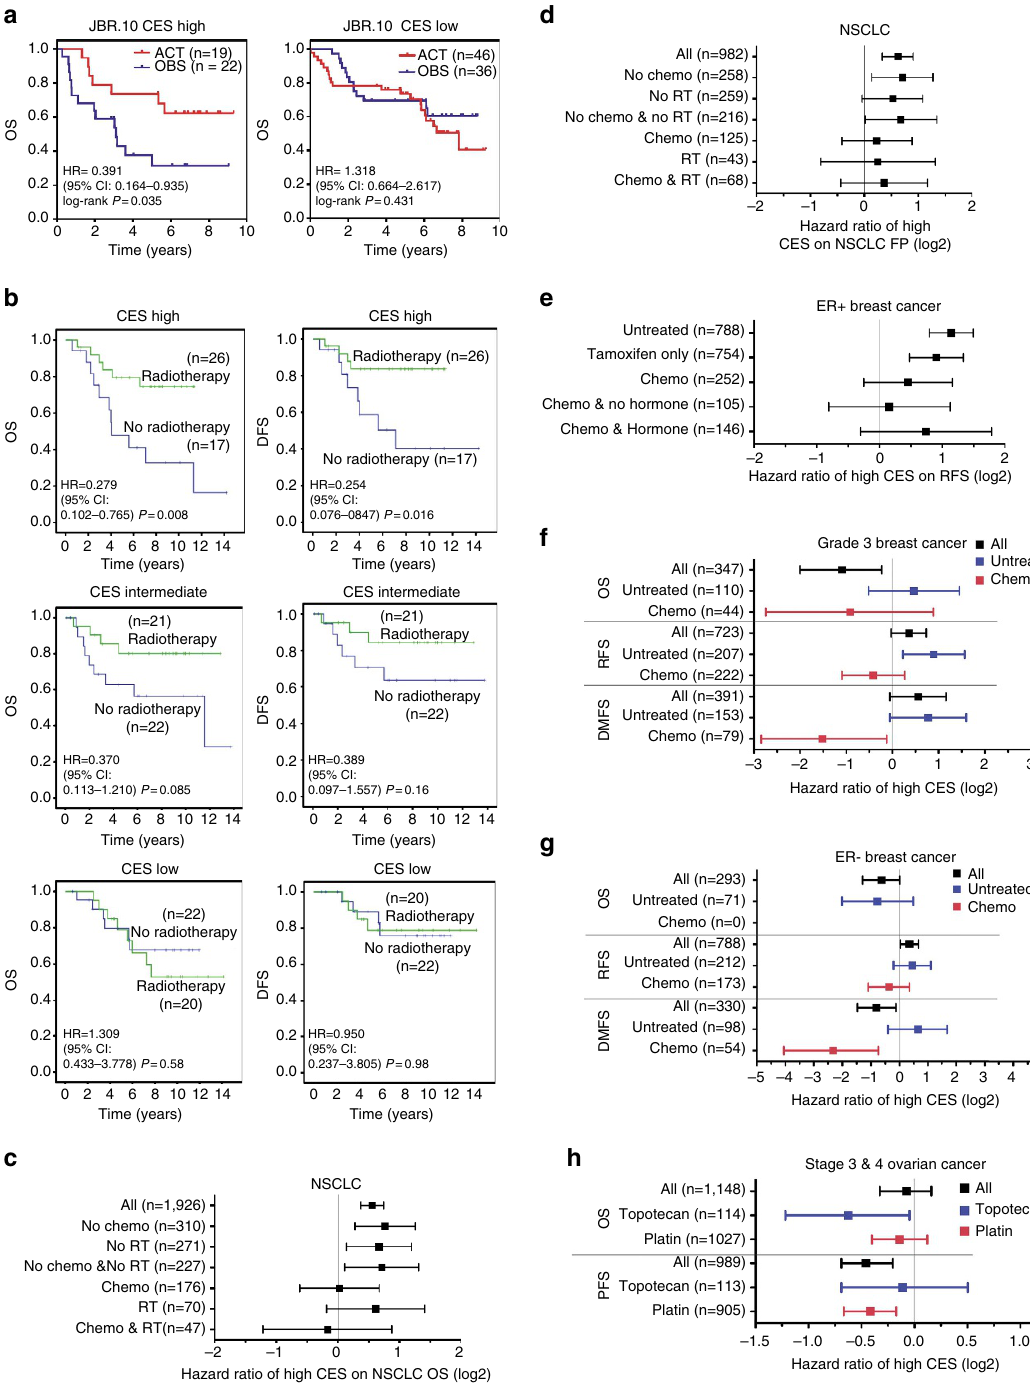
Figure 7 | CES predicts cancer patient outcome after adjuvant chemotherapy or radiotherapy. ( a ) Kaplan–Meier plots showing that high CES predicts better patient outcome after adjuvant chemotherapy (ACT) for early-stage NSCLC patients in JBR.10 trial. ACT significantly improved overall survival compared to no ACT (OBS) specifically for the high CES group (top tertile), but not for the low CES group (lower two tertiles). ( b ) Kaplan–Meier plots showing that high CES predicts better patient outcome after adjuvant radiotherapy (RT) for (left) overall survival (OS) and (right) disease-free survival (DFS) for breast cancer patients using the Gray data set (E-TABM-158). Patient cohort was divided into CES tertiles. There is no significant survival benefit from RT for patients with intermediate (middle) and low (bottom) CES. ( c – h ) Forest plots summarizing treatment-specific hazard ratios of high CES in cancer patient cohorts using K–M Plotter. Squares and error bars in the plots denote log2 scales of hazard ratio (HR) and 95% confidence interval (CI), respectively. ( c ) NSCLC patient overall survival (OS) with or without chemotherapy or radiotherapy (see Supplementary Fig. 27 for Kaplan–Meier plots). ( d ) NSCLC patient first progression (FP) (Supplementary Fig. 29). ( e ) ER þ breast cancer patient relapse-free survival (RFS) with or without tamoxifen or chemotherapy (Supplementary Fig. 30). ( f ) Grade 3 breast cancer patient survival with or without chemotherapy (Supplementary Fig. 31). ( g ) ER (cid:2) cancer patient survival (Supplementary Fig. 32). ( h ) Stage 3 and 4 combined ovarian cancer patient overall survival and progression-free survival (PFS) with topotecan or platinum treatments (Supplementary Fig.